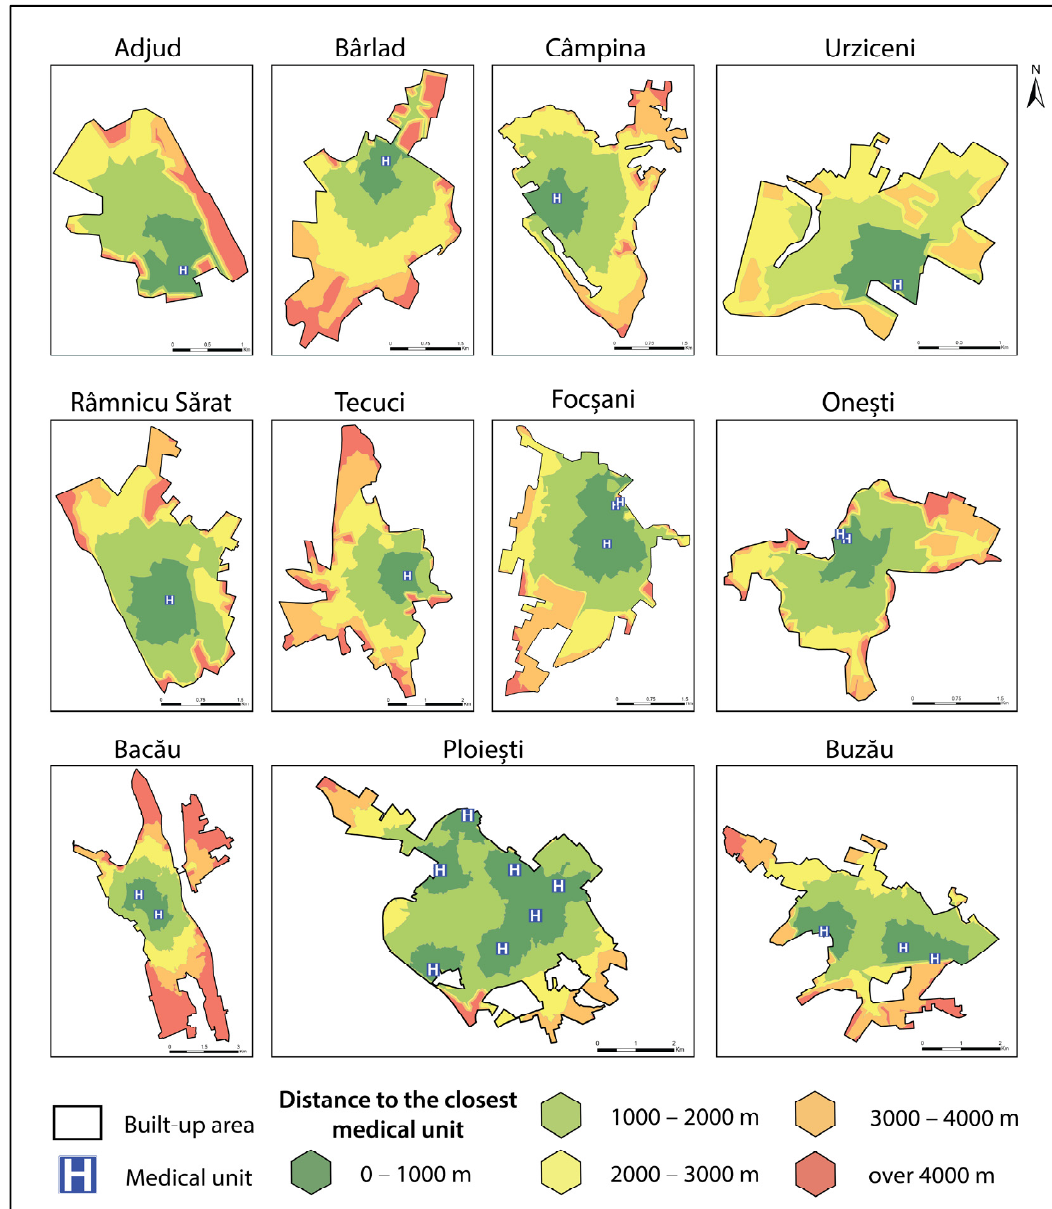
Figure 5. The service areas of the medical units in the 11 urban settlements. Service areas extend towards medical facilities. The scale was adapted for each urban settlement to better portray the service areas.